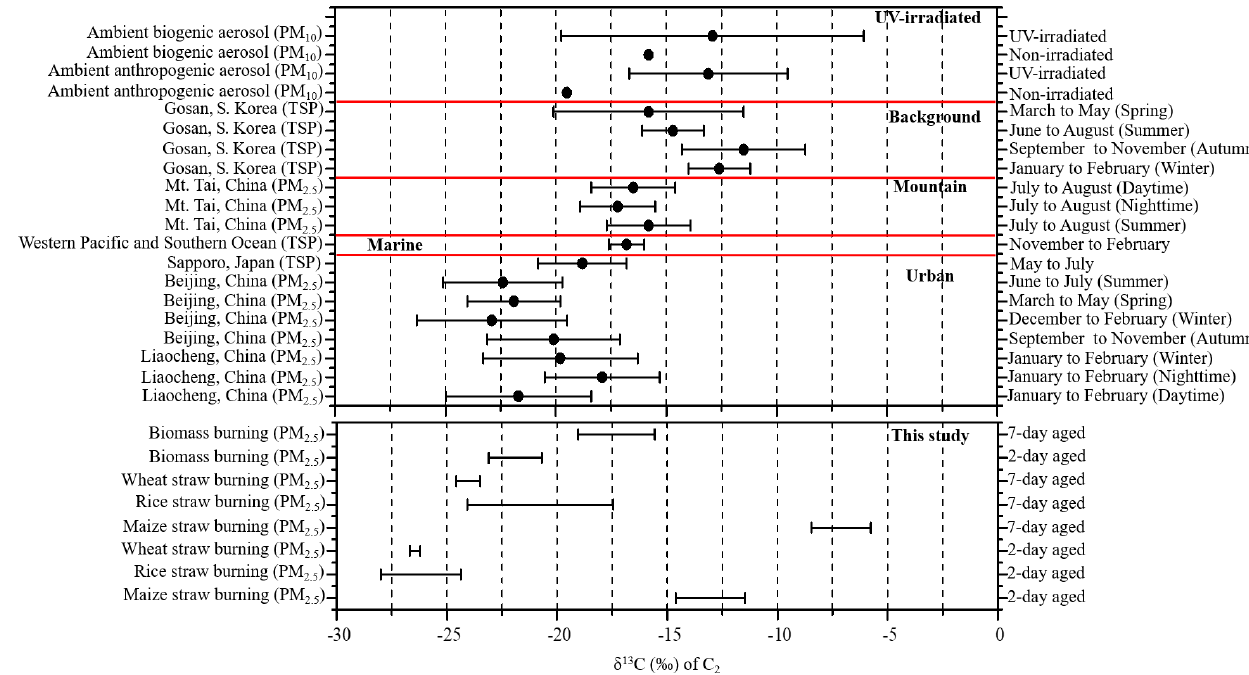
Figure 4. Stable carbon isotope ratios ( δ 13 C, ‰) of C 2 in aerosols from selected